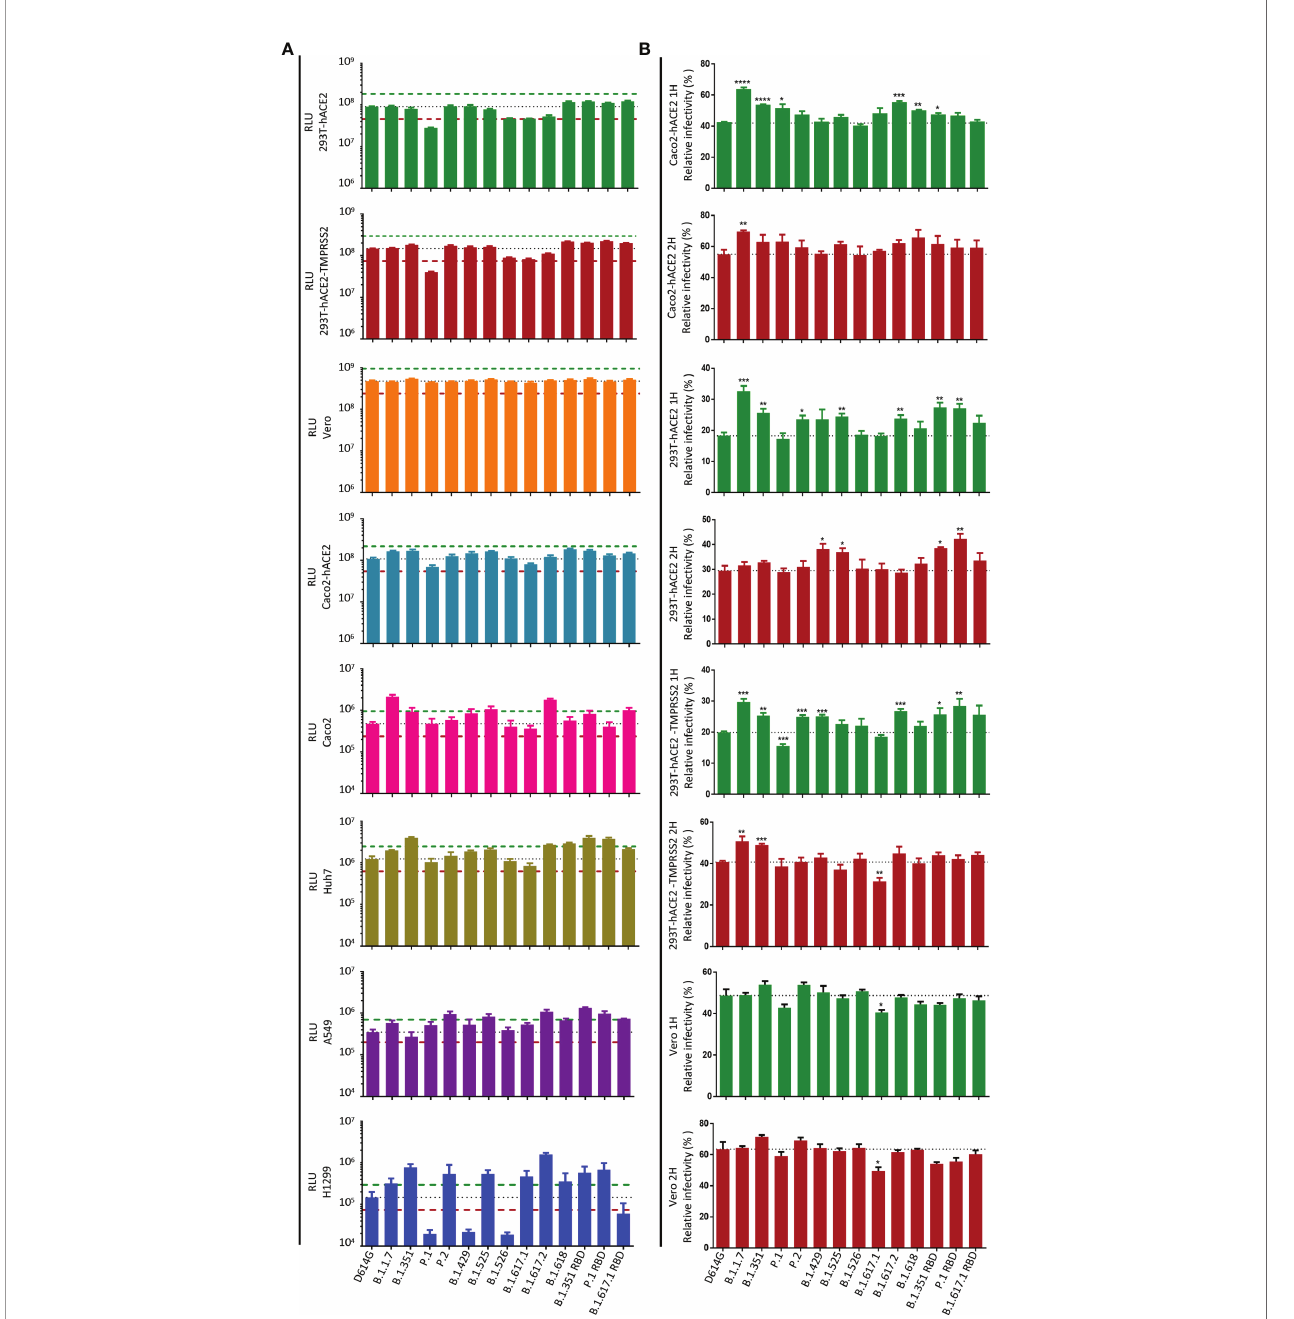
FIGURE 2 | Infectivity analysis of SARS-CoV-2 variants in mammalian cell lines. (A) Entry of SARS-CoV-2 variants S pseudoviruses in mammalian cells. Mammalian cells were inoculated with pseudoviruses harboring SARS-CoV-2 variants S protein. At 24 h postinoculation, luciferase activity in cell lysates was measured to detect infection ef fi ciency. The infectivity of the D614G variant was used as a control. The dashed lines indicate the threshold value of a 2-fold difference in infectivity. (B) SARS-CoV-2 variants S pseudoviruses were incubated with Caco2-hACE2, 293T-hACE2, 293T-hACE2-TMPRSS2, and Vero cells, then the unbound virus was removed by washing at the speci fi ed time point (1 or 2 h), and the unwashed cells were used as the control. At 24 h, luciferase activity in cell lysates was measured to detect infection ef fi ciency. The infection ef fi ciency of the virus was calculated by dividing the relative luminescence unit (RLU) value at each time point by the average RLU value of the respective virus at 24 h. A p-value less than 0.05 was de fi ned as statistically signi fi cant (p < 0.05 [*], p < 0.01 [**], p < 0.001 [***], p < 0.0001 [****]). Experiments were done in 4 replicates and repeated at least twice. One representative is shown with error bars indicating